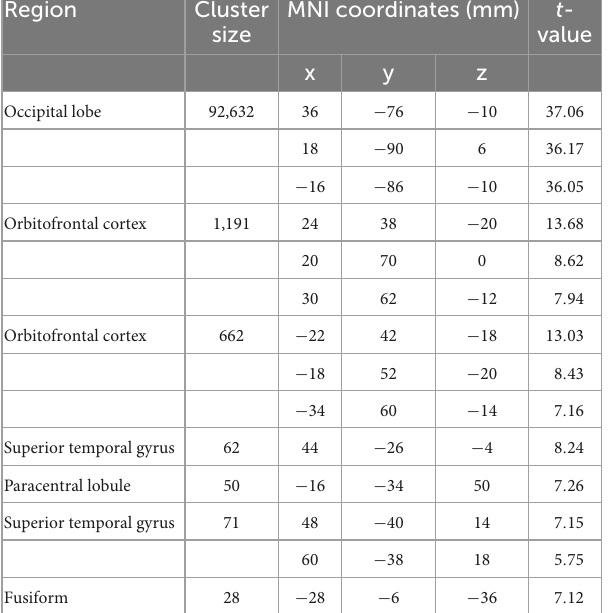
TABLE 1 Brain regions showing significant larger activation in the contrast of LL > SS.